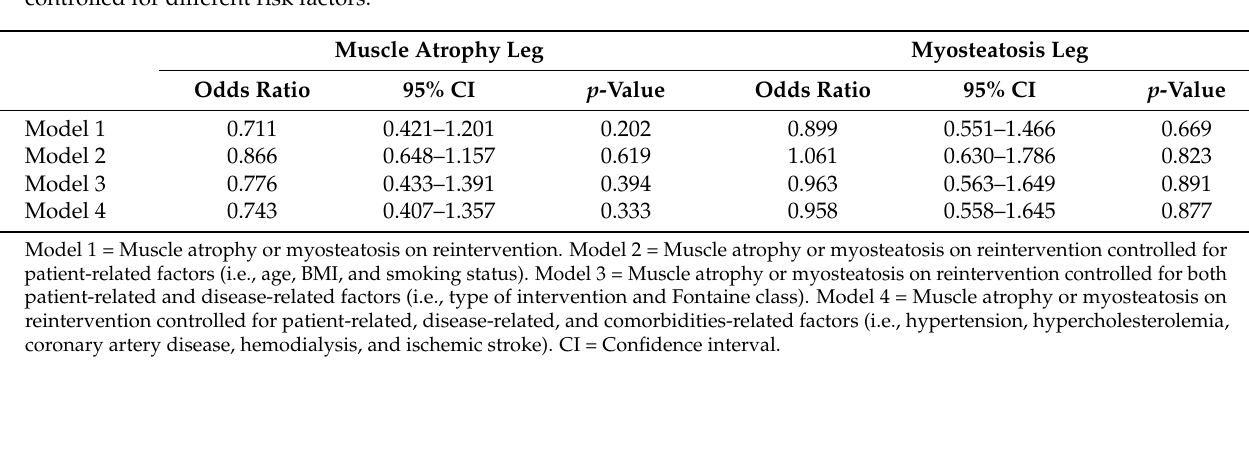
Table 3. Binary logistic regression for the impact of muscle atrophy or myosteatosis on reintervention in four models controlled for different risk factors.